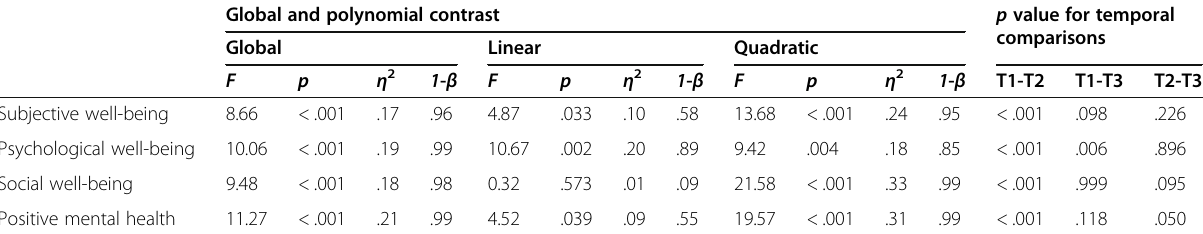
Table 3 Repeated measures ANOVA for outcome variables Global and polynomial contrast